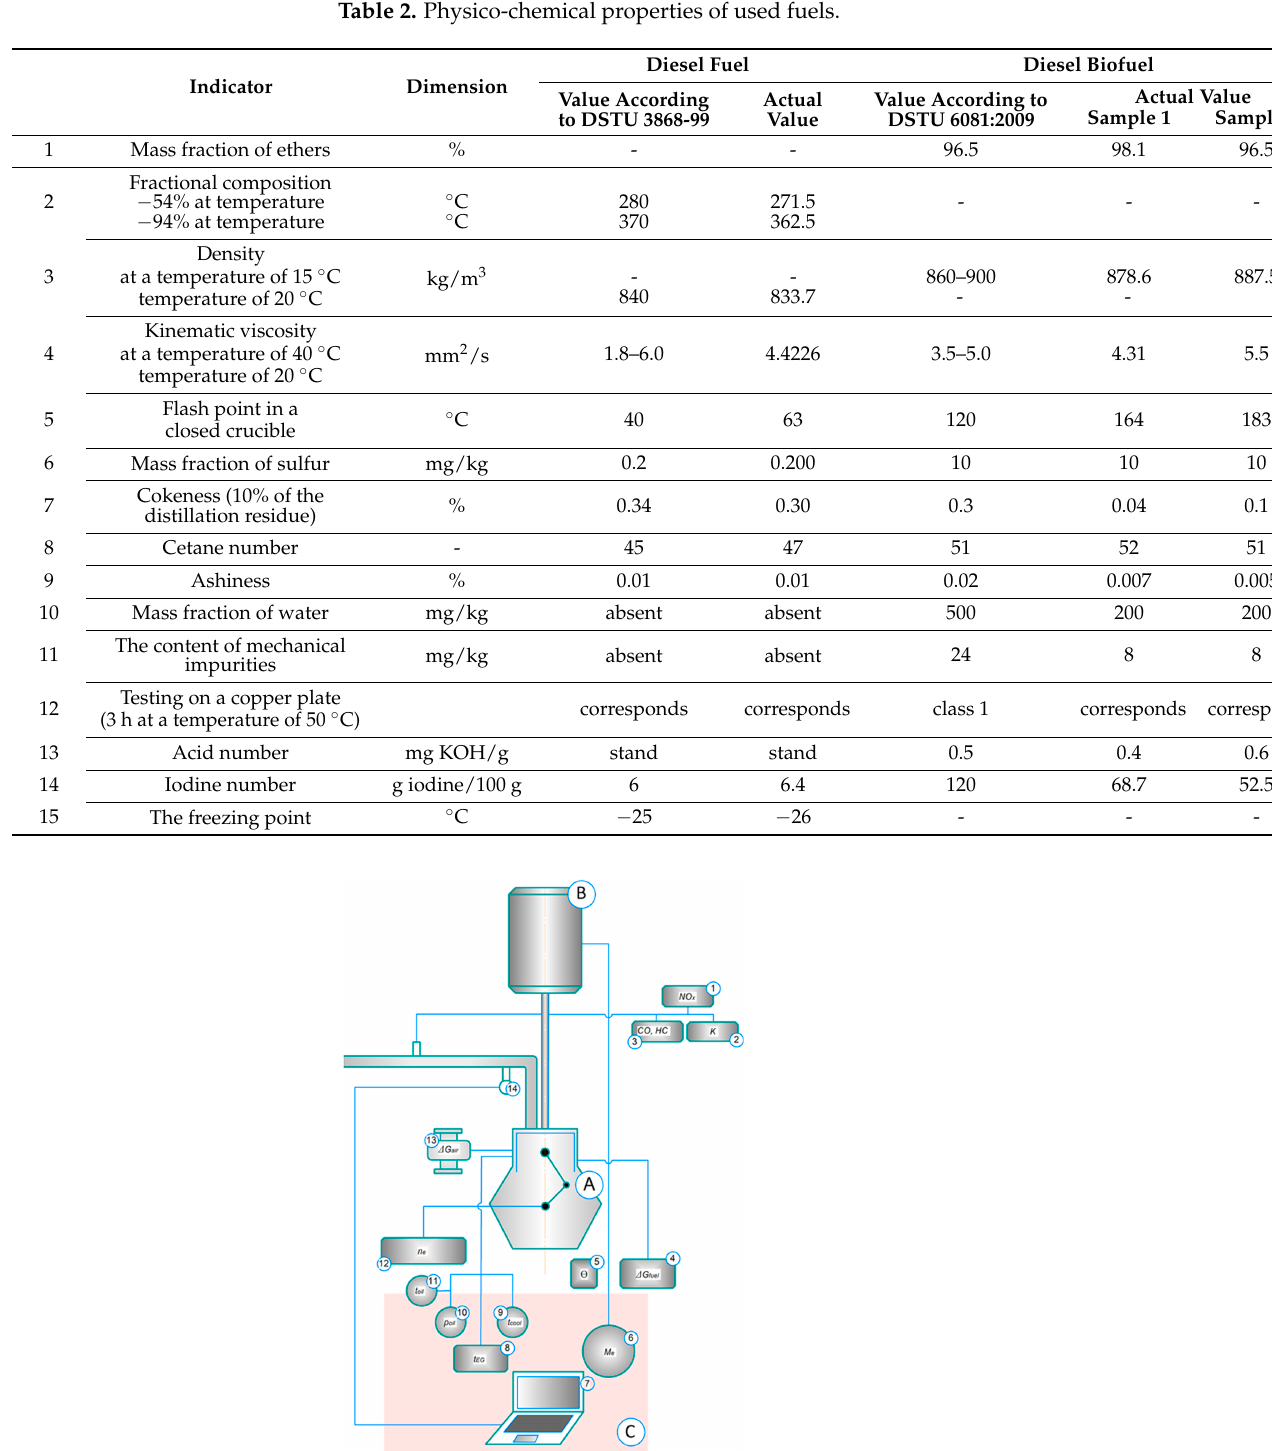
Table 2. Physico-chemical properties of used fuels.